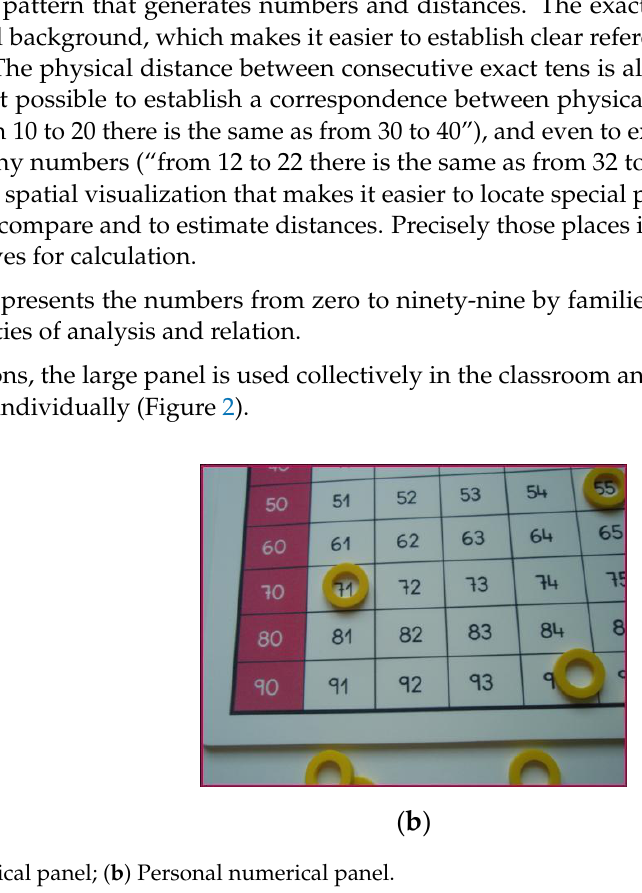
Figure 1. Detail of the number line.